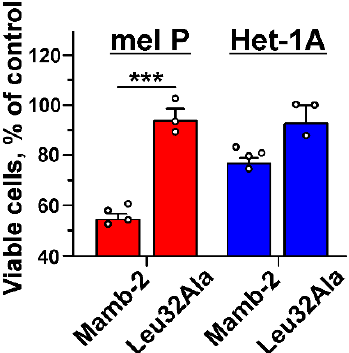
Figure 10. Influence of mambalgin-2 and its Leu32Ala mutant on proliferation of mel P and Het-1A cells. Toxins’ concentration in the cell media was 1 μ M. Data are presented as % of the control (untreated cells, dashed line) ± SEM ( n = 3–4). *** ( p < 0.001) indicates significant difference in the activity of mutant and mambalgin-2 according to two-tailed t -test.